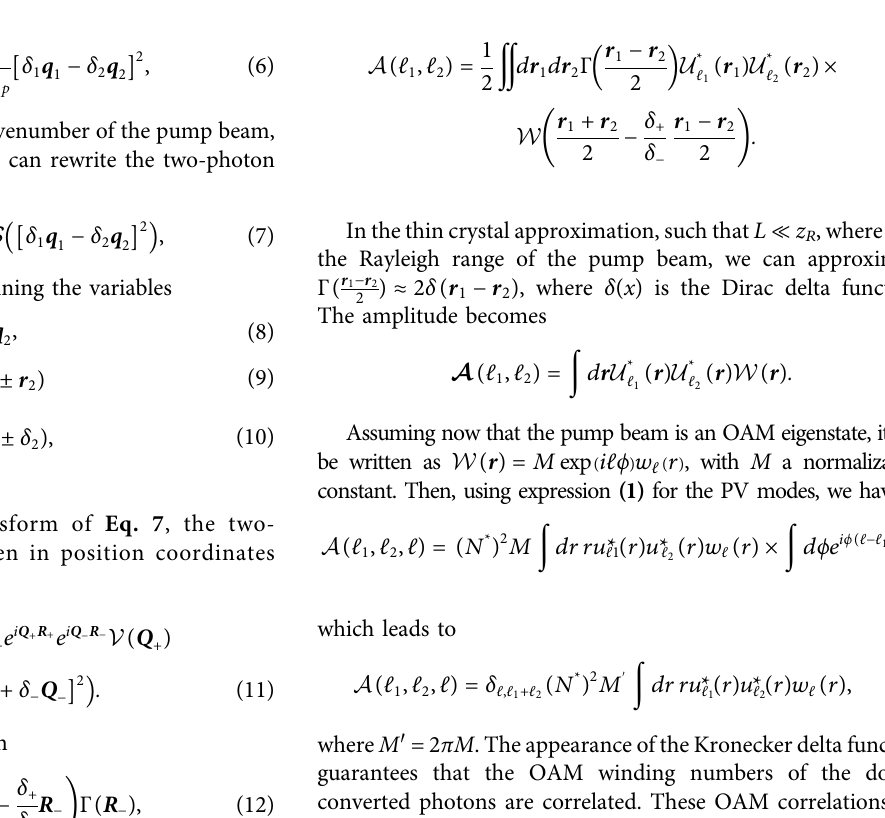
FIGURE 2 | (A) Illustration of a Ring-Core Fiber (RCF). (B) , (D) Pro fi les of perfect vortex modes and (C) , (E) superpositions of perfect vortex